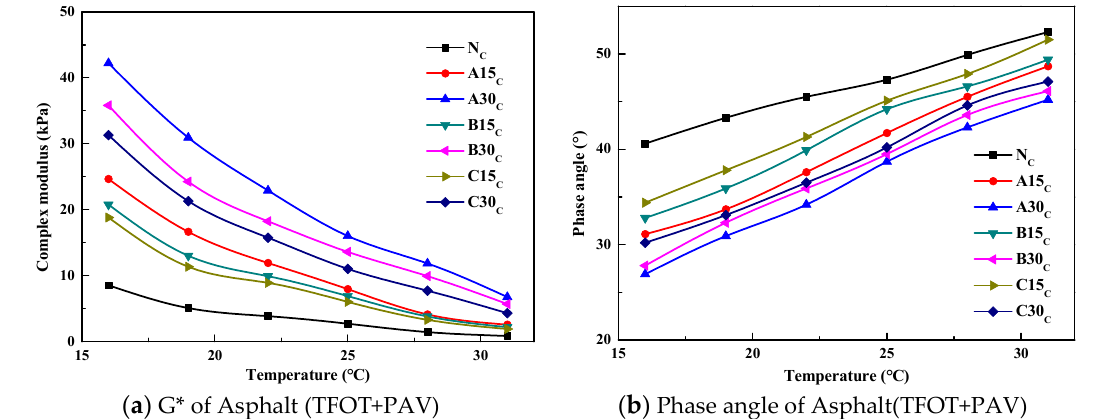
Figure 4. The results of the complex modulus and phase angle versus temperature for the long-term aged asphalt. aged